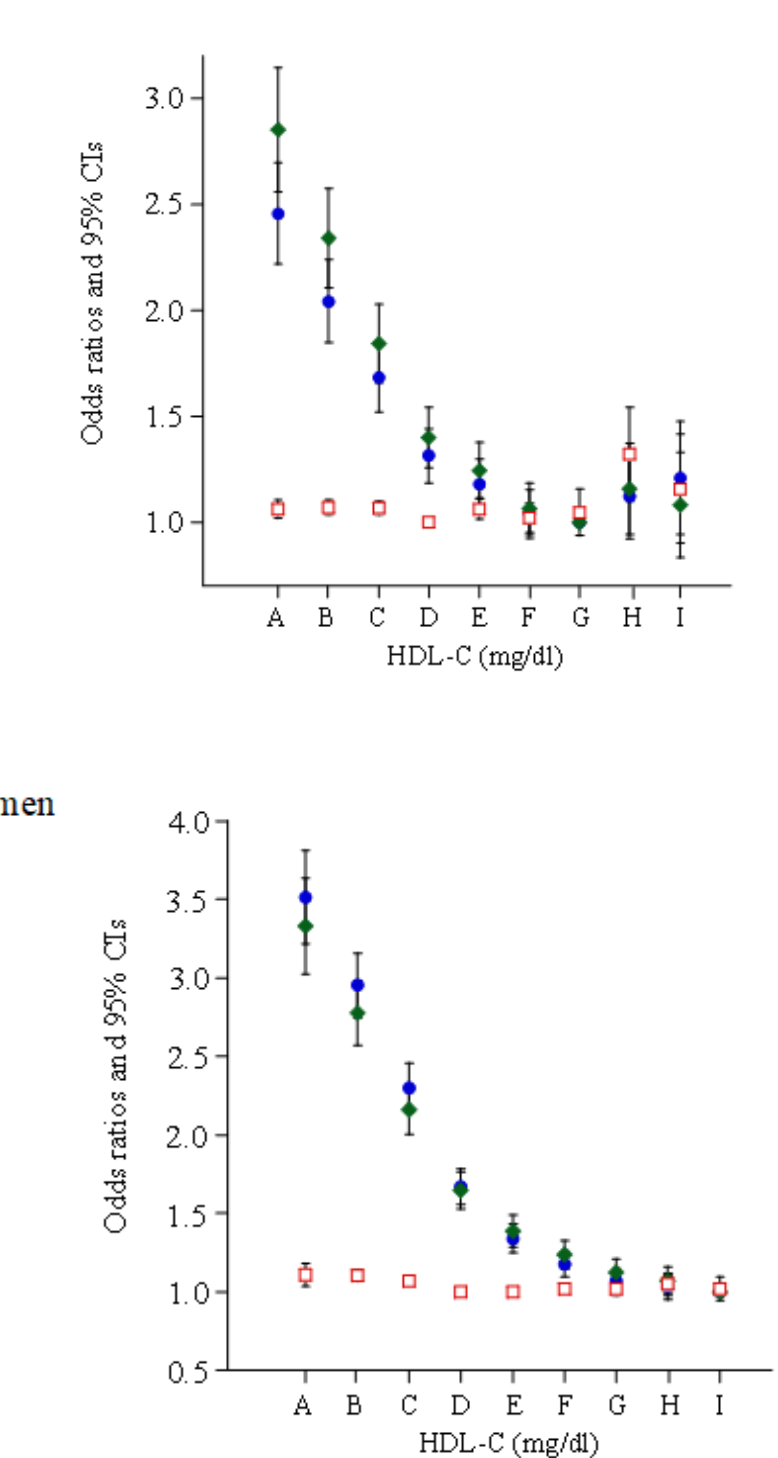
Figure 3. Odds ratios of nine HDL-C concentration categories for HBP in subjects who hardly consumed alcohol. Closed blue circle: unadjusted. Closed green diamond: adjusted for age, sex (whole subjects), smoking, pharmacotherapy (for diabetes mellitus or dyslipidemia), habitual exercise, and daily alcohol consumption. Open red square: plus adjusted for body mass index and serum concentration of triglyceride A, 20–39; B, 40–49; C, 50–59; D, 60–69; E, 70–79; F, 80–89; G, 90–99; H, 100–109; I, ≥ 110 mg/dL.